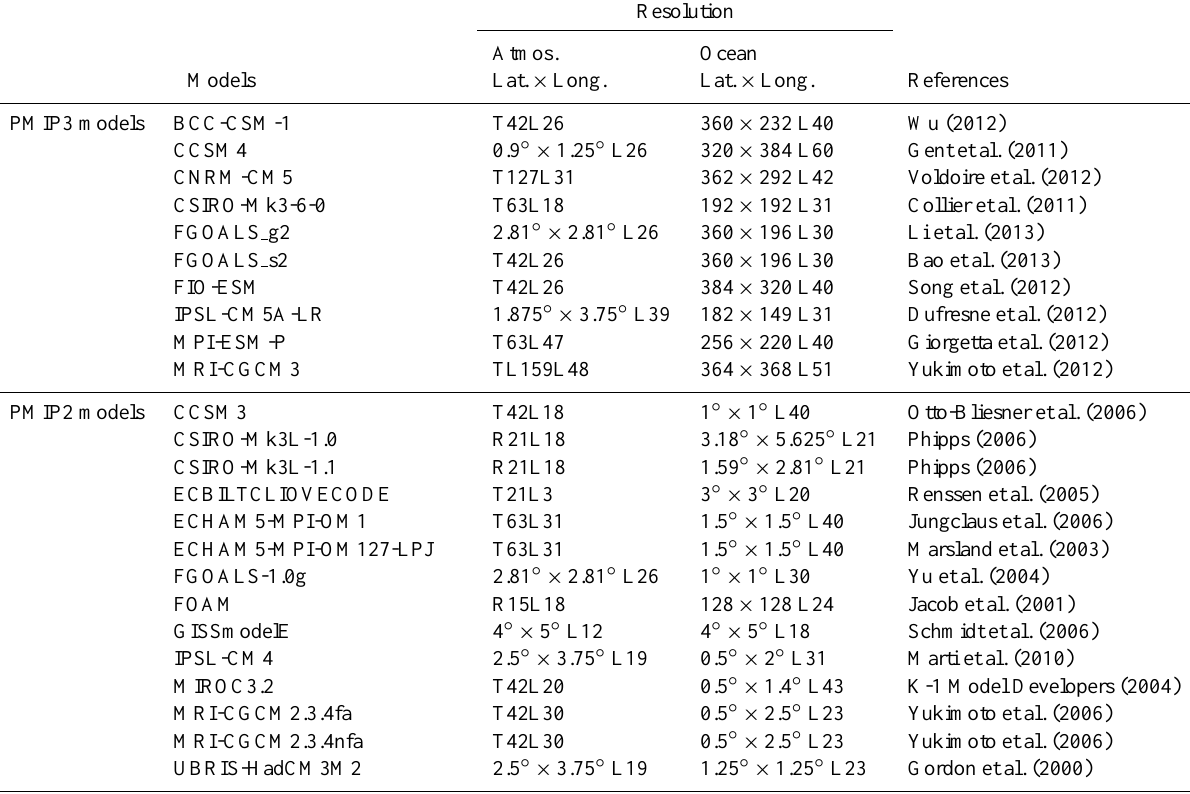
L’Institut Pierre-Simon Laplace Coupled Model (IPSL-CM); Meteorological Research Institute Coupled General Circulation Model (MRI- CGCM); and the Met Office model run at Bristol University (UBRIS); and third climate configuration of the Met Office Unified Model (HadCM3).